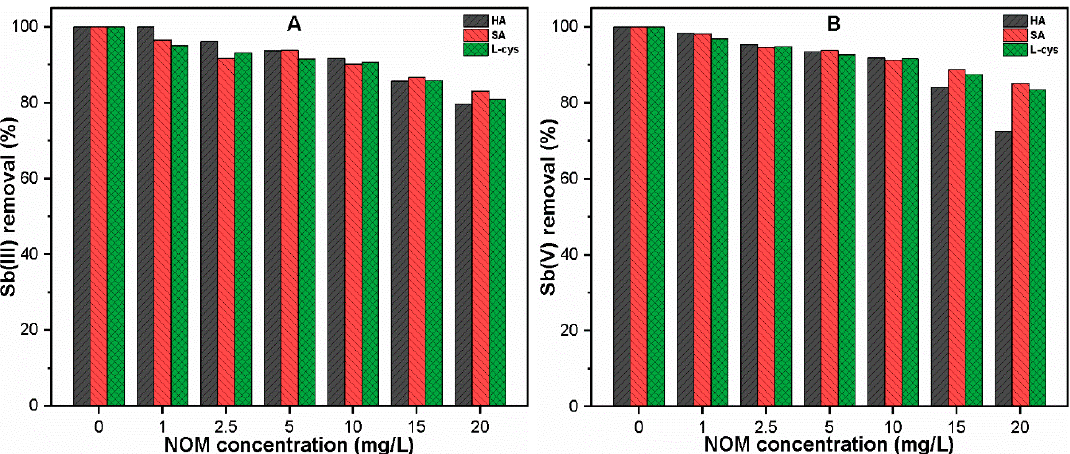
Figure 4. Under optimum FC doses, ( A ) Sb(III); and ( B ) Sb(V) removal at various NOM concentrations (0–20 mg/L) is shown.